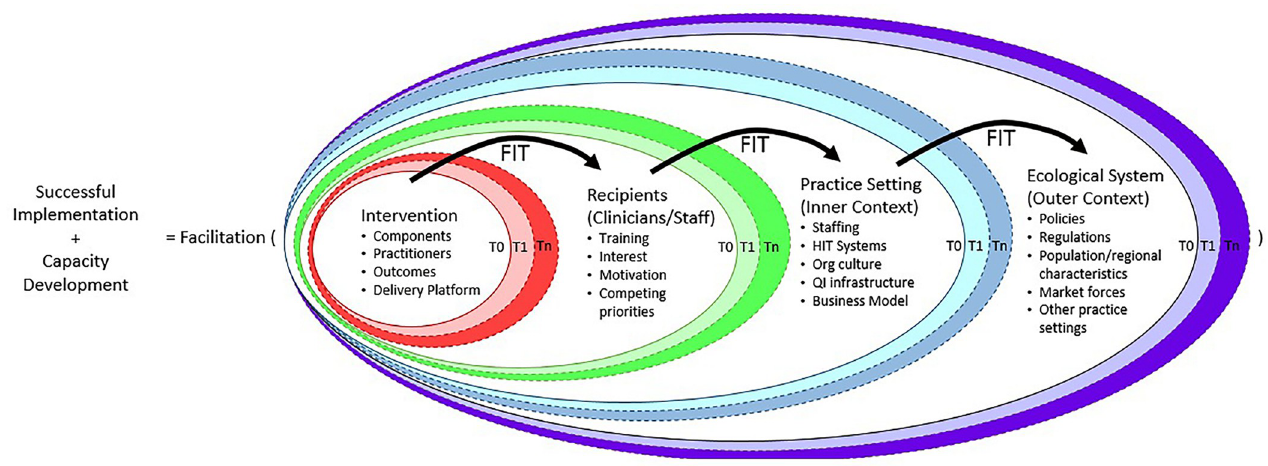
Fig 1. Hybrid framework combining the Integrated Promoting Action on Research Implementation in Health Services (i-PARIHS) and the Dynamic Sustainability Framework (DSF). Successful implementation and capacity development are a function of facilitation interacting with the intervention, recipients, practice setting, and the ecological system over time (represented by T0, T1, ... ,Tn), each of which has constituent components that may vary. HIT = Health information technology; org = Organization; QI = Quality